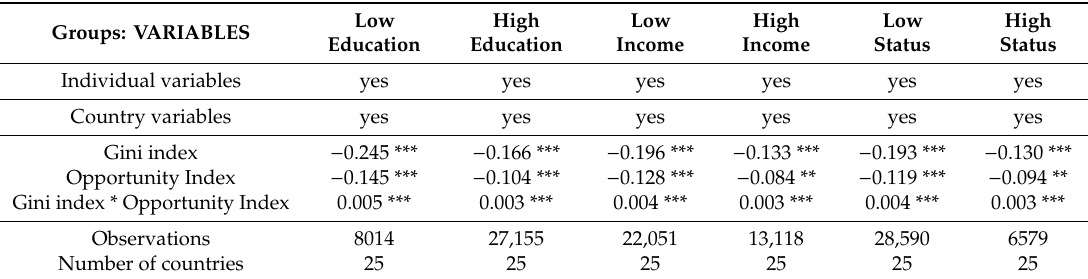
Table 3. Determinants of life satisfaction for di ff erent